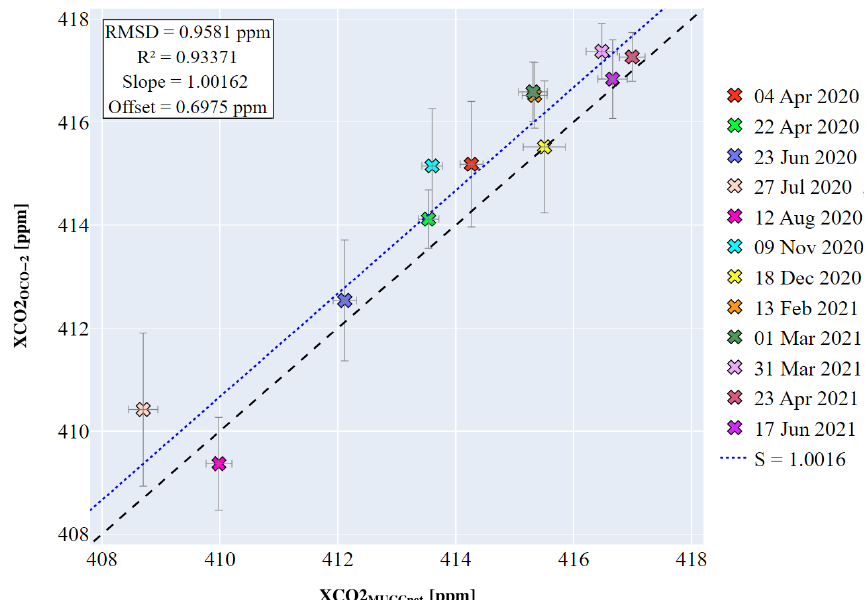
Figure 7. Scatter plot of X CO captured by the MUCCnet center site and OCO-2 target data. We consider all good-quality soundings within 2 the target area. Each overpass is color-coded. The error bars represent the standard deviations of the samples in the corresponding domain.